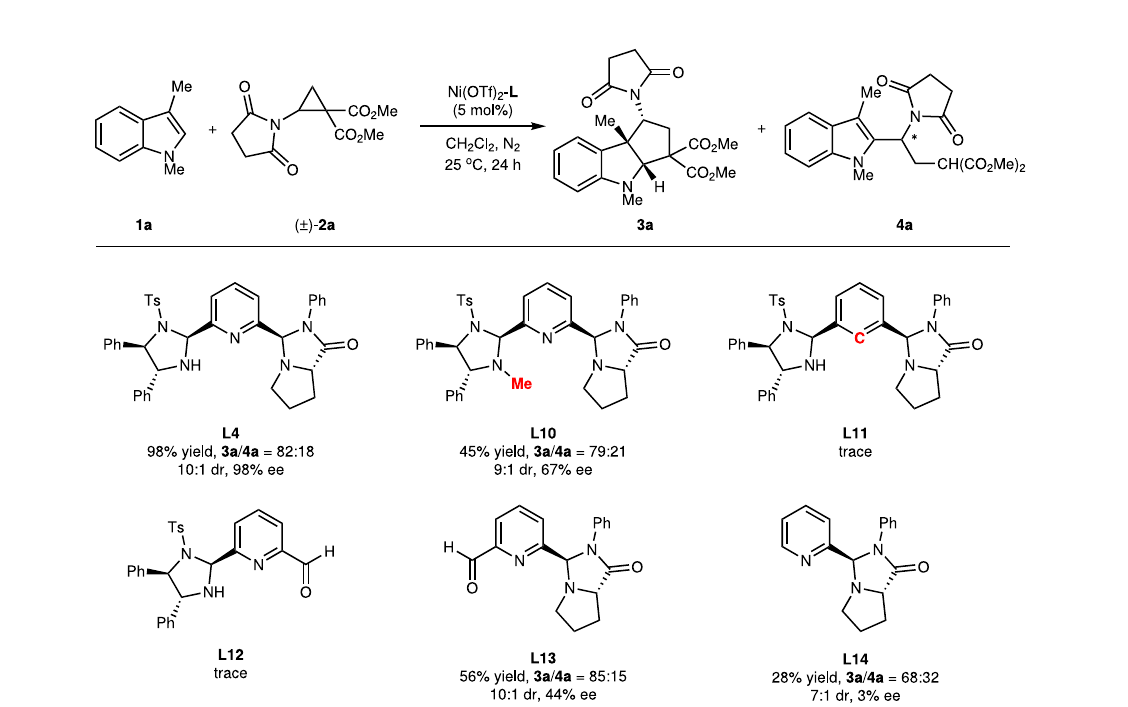
Fig. 5 | Control experiments. Reaction conditions: Ni(OTf) 2 / L (1:1.2, 5mol%), 1a (0.1mmol), 2a (0.22mmol) in CH 2 Cl 2 (2.0mL) at 25°C under N 2 for 24h; The total yield ( 3a + 4a ) and dr value of 3a were determined by 1 H NMR spectra of the crude product; The ee value of 3a was determined by chiral HPLC analysis.